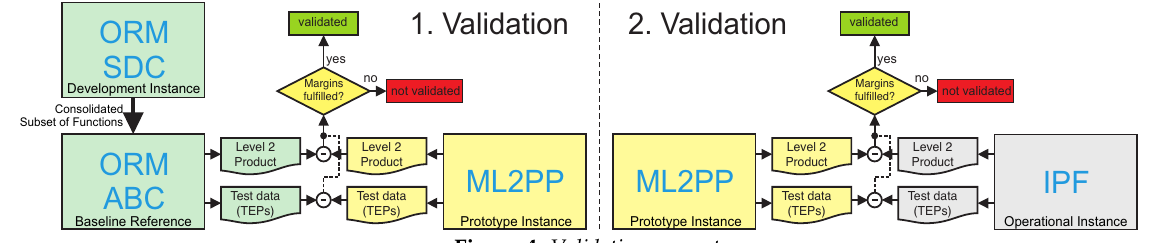
Figure 4: Validation